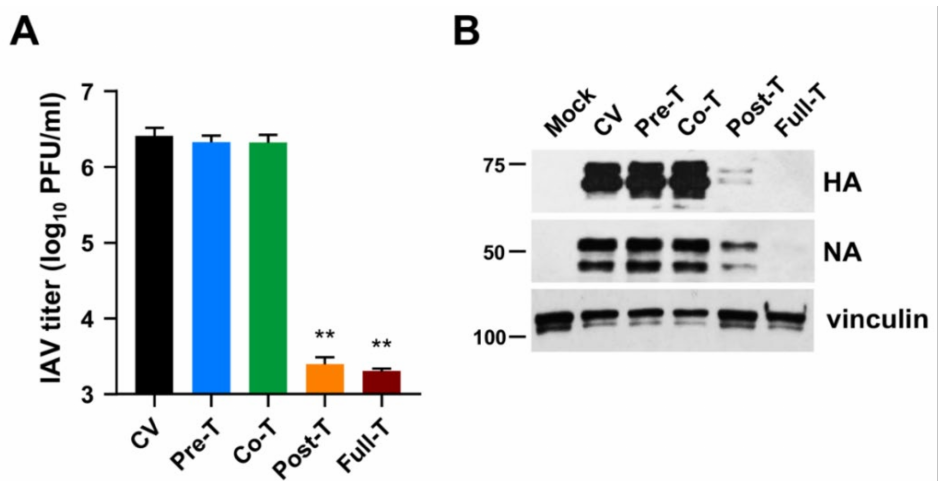
Figure 4. MEDS433 targets a post-entry phase of the IAV replicative cycle. MDCK cell monolayers were infected with IAV at an MOI of 0.1 and, where indicated, treated with 0.5 µ M MEDS433 1 h prior to the infection (from − 2 to − 1 h, Pre-T ), or during the infection (from − 1 to 0 h, Co-T ), or after infection (from 0 to 48 h p.i., Post-T ;), or from − 2 to 48 h p.i. ( Full-T ). Mock-infected cells ( Mock ) and control IAV-infected cells ( CV ) were exposed to DMSO only. ( A ) Cell supernatants harvested at 48 h p.i. were titrated by the plaque assay, and viral plaques were microscopically counted and plotted as PFU/mL. The data shown are the means ± SD of two independent experiments performed in triplicate and analyzed by a one-way ANOVA followed by Dunnett’s multiple comparison test. ** ( p < 0.001) compared to the calibrator sample ( CV ). ( B ) Total cell extracts were prepared at 48 h p.i., fractionated by 8% SDS-PAGE, and analyzed by immunoblotting with anti-IAV HA and anti-IAV NA pAbs. Vinculin immunodetection was used as a control for protein loading. Molecular weight markers are shown next to the left side of each